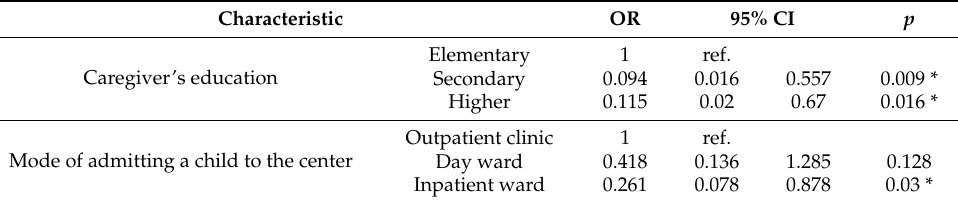
Table 14. Predictors of comorbidity of anxiety and depression: multivariate analysis (two variables). Characteristic OR 95% CI p Elementary 1 ref. Caregiver’s education Secondary 0.094 0.016 0.557 0.009 * Higher 0.115 0.02 0.67 0.016 * Outpatient clinic 1 ref. Mode of admitting a child to the center Day ward 0.418 0.136 1.285 0.128 Inpatient ward 0.261 0.078 0.878 0.03